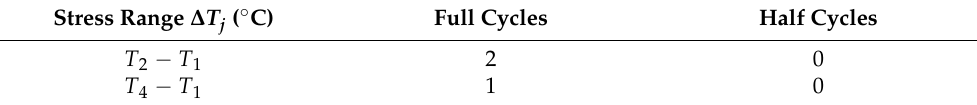
Table 11. Half-cycle matching and rainflow-counting results using the reduced thermal